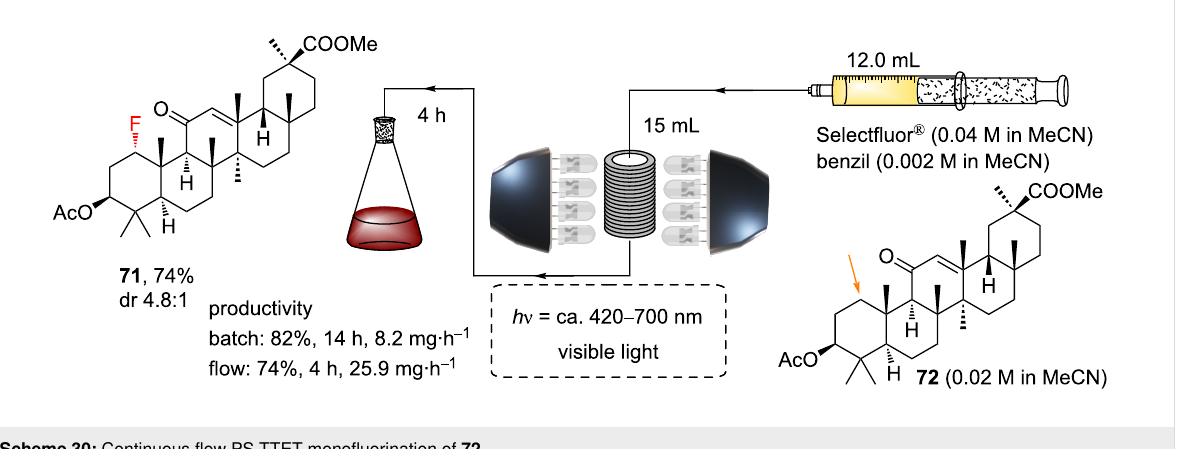
Scheme 30: Continuous flow PS TTET monofluorination of 72